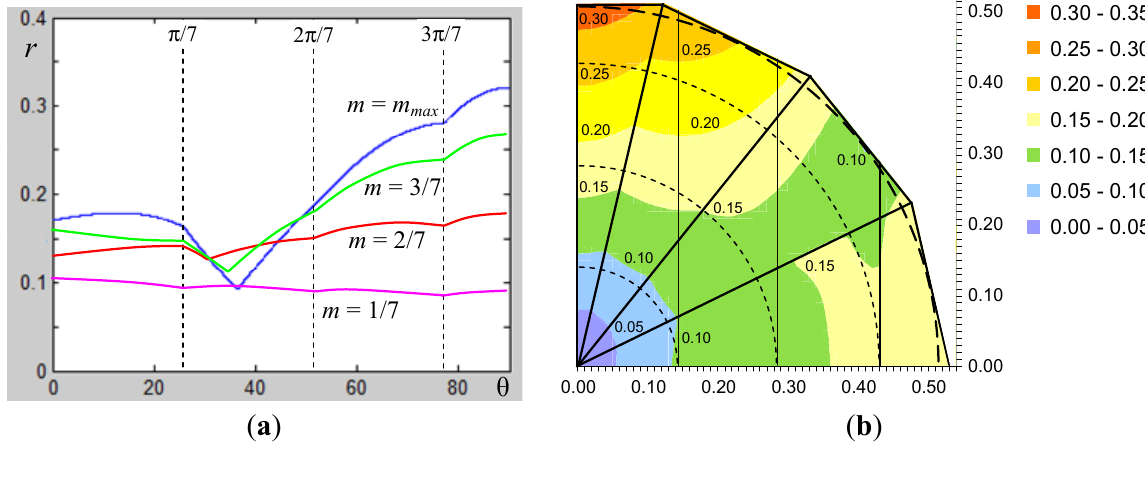
Figure 7. Diagrams of the normalized peak-to-peak current ripple amplitude r ( m , θ ). ( a ) As a function of the phase angle θ in the range [0, π /2], for different modulation indexes; and ( b ) colored map in the space vector plane α – β within the modulation